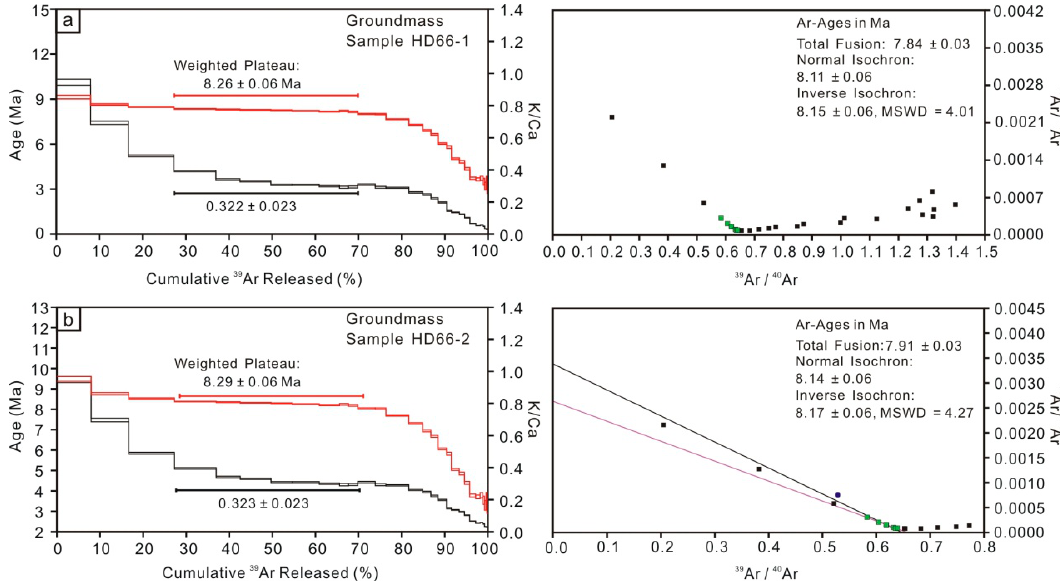
Figure 8. ( a , b ) Age spectra, integrated and plateau ages, and isochron diagrams of the Nanyue basalts.